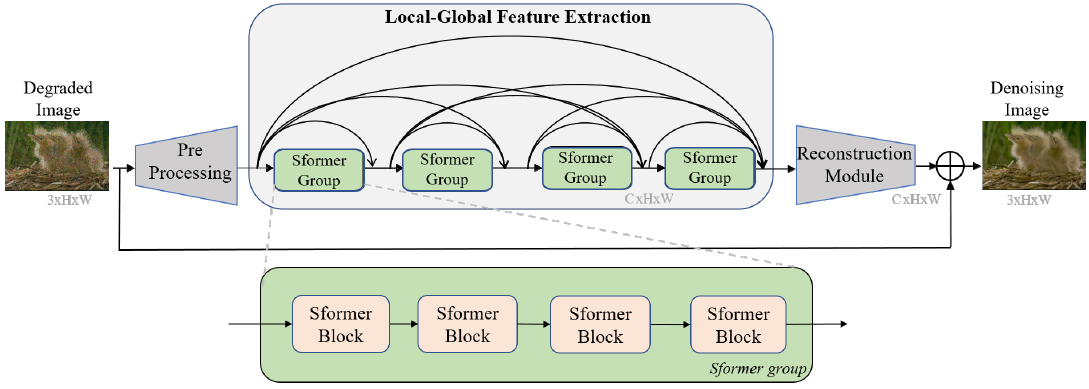
Figure 1. Architecture of the